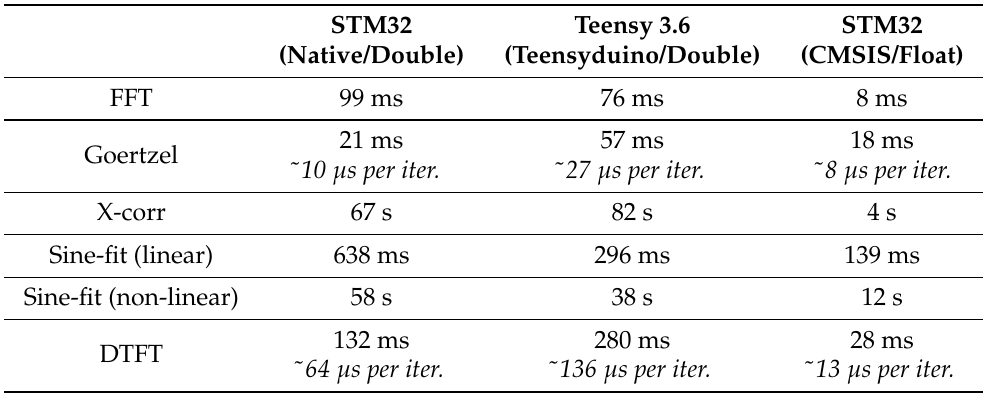
Table 8. Total AC signal analysis Processing Time as Implemented in Non-accelerated and Hardware- accelerated Environment in STM32 and Teensyduino 3.6.